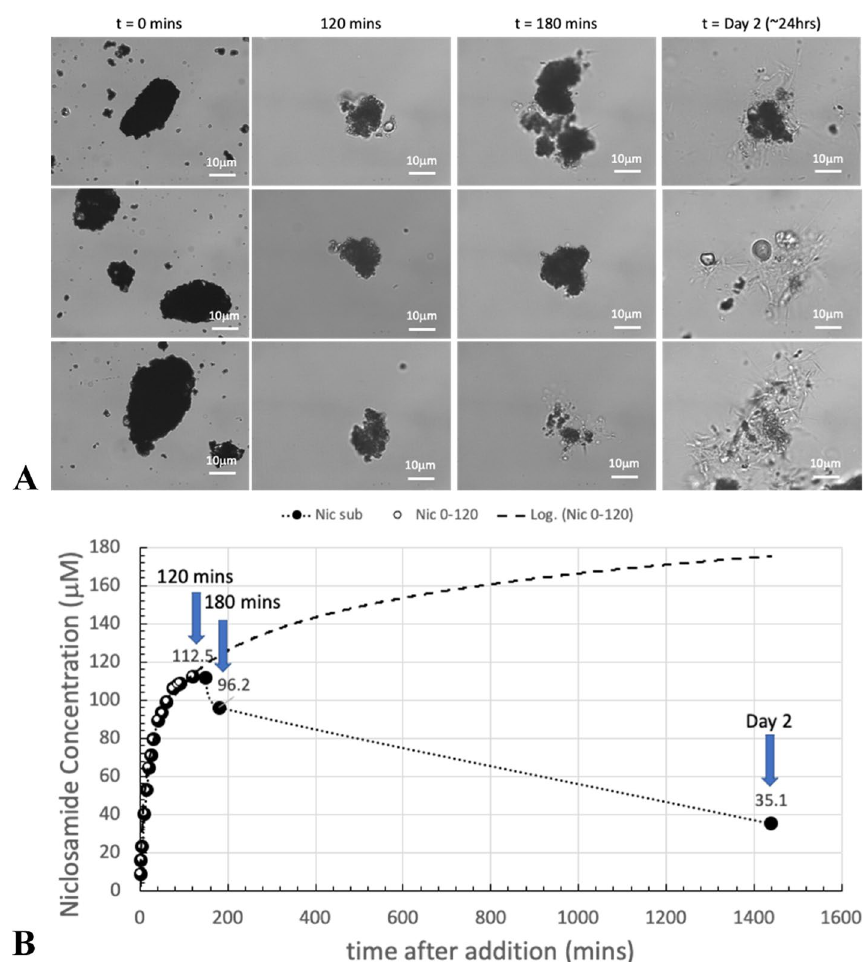
Fig. 14 Dissolution of 600 µM Yomesan-niclosamide at nominal pH 8.85. A Optical microscope images of Yomesan-niclosamide particles before ( t 0mins), during ( t 120 min and 180 min), and after equilibration (day 2). B Dissolution profile from Fig. 8C, extended to day 2. 40 = = Scale bars are 10 μm in bright field Kohler illumination optics (Nikon